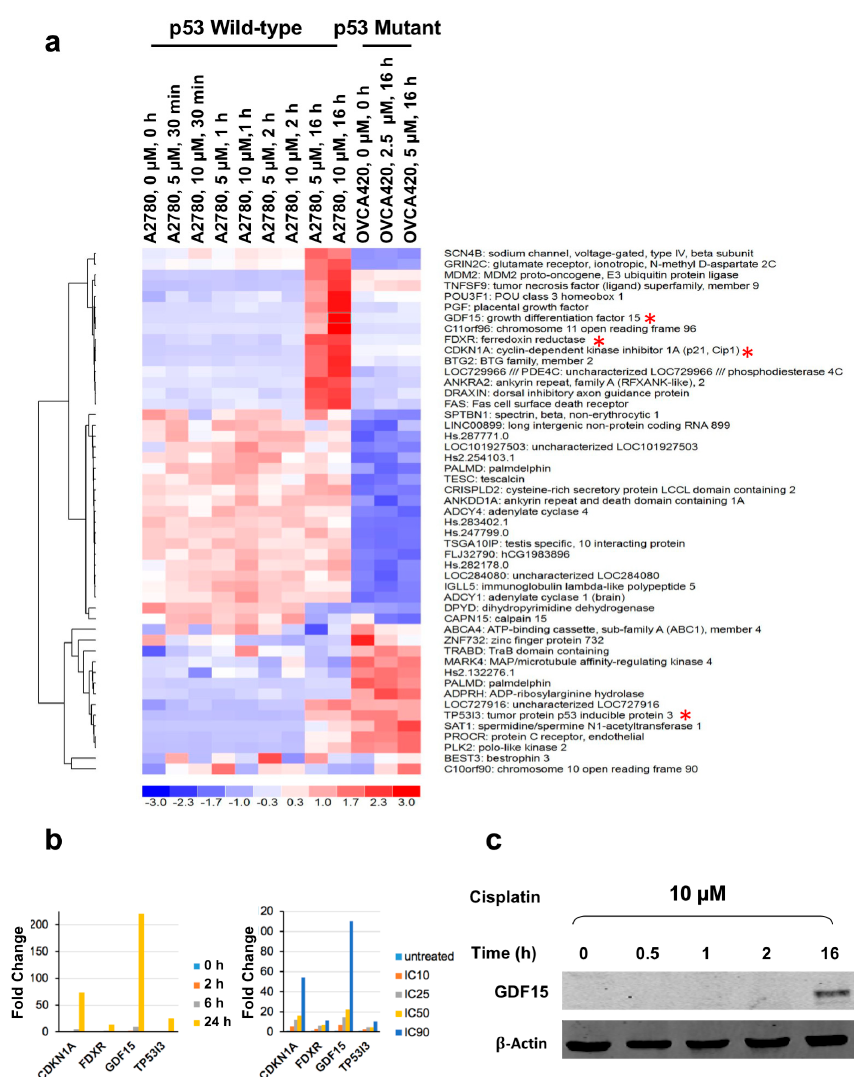
Figure 1. Di ff erentially expressed genes identified by microarray analysis in wild-type p53 A2780 ovarian cancer cell line treated with cisplatin: ( a ) Heat map of genes with di ff erential expression in the A2780 ovarian cancer cell line induced by treatment with cisplatin. The expression of these genes in the p53 mutant OVCA420 cell line was also shown. The color bar at the bottom indicates the fold change in reference to the expression value at zero hour on log2 scale; * indicated the genes validated in ( b ); ( b ) Validation of the up-regulation of the four genes by semi-quantitative RT-PCR analysis performed using total RNA extracted from A2780 cells treated with cisplatin at increasing doses (2.5, 4.5, 5.75, and 25 µ M) for 16 h or a single dose at IC90 for di ff erent times (in triplicate); ( c ) Western blot showing expression of GDF15 in A2780 cells that were treated by cisplatin as